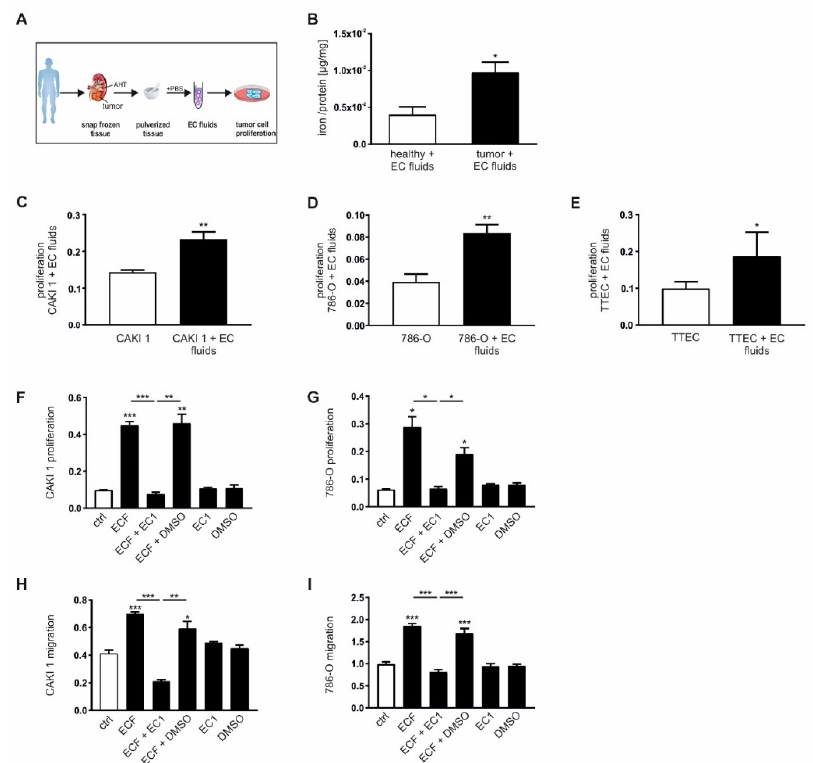
Figure 4. Extracellular iron induces proliferation and migration of tumor cells in vitro. ( A ) Schematic overview of how to generate extracellular (EC) fluids (ECF) from primary human renal tumor and adjacent healthy tissue. ( B ) Iron load measured by AAS relative to the total protein amount of EC fluids of ccRCC tissue compared to adjacent healthy renal tissue ( n = 8). Proliferation of ( C ) CAKI-1 ( n = 7), ( D ) 786-O ( n = 8), and ( E ) primary human tumor tubular epithelial cells (TTEC) upon stimulation with EC fluids in vitro measured with the xCELLigence system ( n = 8). Proliferation of (F) CAKI 1 ( n = 4) and ( G ) 786-O ( n = 4) cells as well as migration of ( H ) CAKI 1 ( n = 4) and ( I ) 786-O cells ( n = 4) upon stimulation with EC fluids in the presence or absence of an extracellular chelator (EC1, 100 µ M) or dimethyl sulfoxide (DMSO) as negative control measured with the xCELLigence system. Graphs are displayed as means ± SEM with * p < 0.05, ** p < 0.01, *** p <